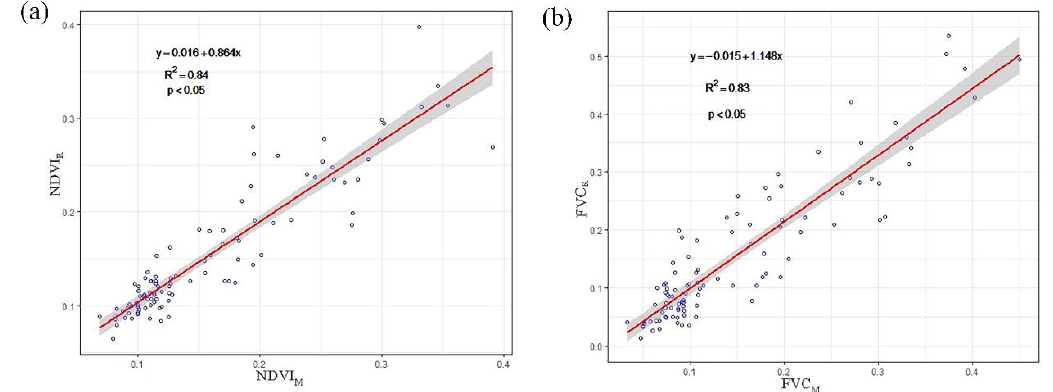
Figure 6. Linear relationships of ( a ) NDVI R and NDVI M , ( b ) and FVC R and FVC M .